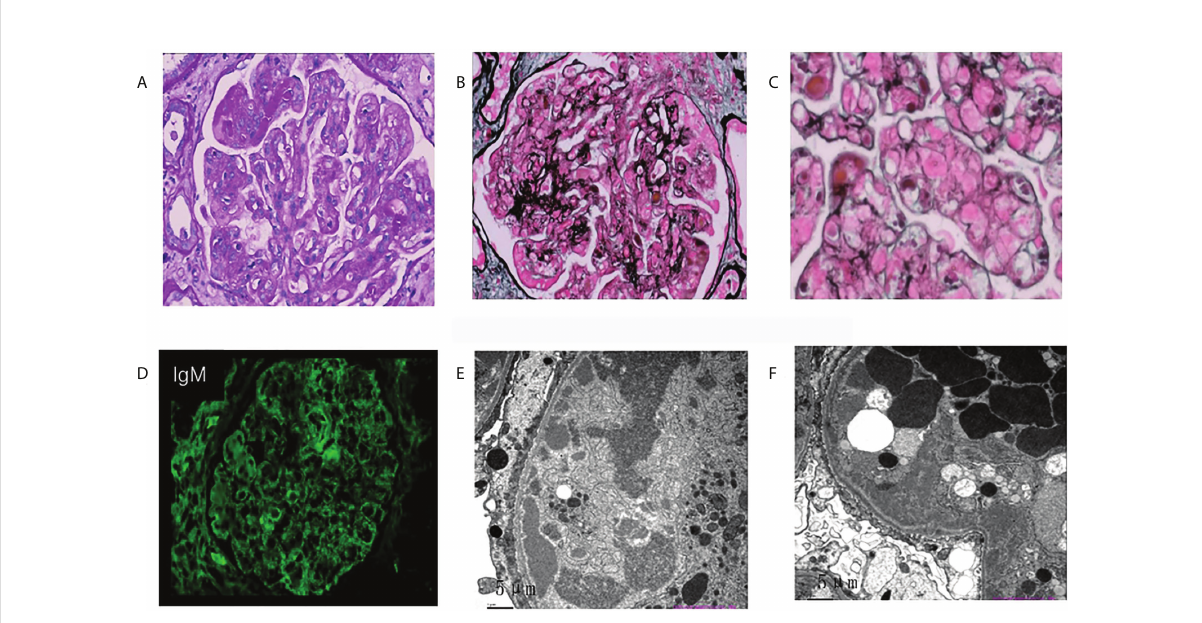
FIGURE 3 Morphologic features of membranoproliferative glomerulonephritis on renal biopsy of the patient with Waldenstrom ’ s macroglobulinemia. (A) Mesangial cells were severely proliferated and lobulated, and mesangial matrix was moderately increased. (asterisks; PAS, original magni fi cation×400). (B, C) Deposits were observed in mesangial, subcutaneous and subepithelial areas (PASM. b, original magni fi cation×400; c, original magni fi cation×600). (D) Deposits stained with IgM in the mesangial area and para mesangial area by immuno fl uorescence (original magni fi cation×400). (E, F) ByEM, electron-dense deposits were observed in the subendothelial, mesangial area and medial of basement membrane. Foot processes showed diffuse fusion (original magni fi cation×2500). PAS, periodic acid – Schiff; PASM, periodic acid-silver metheramine; EM, electron